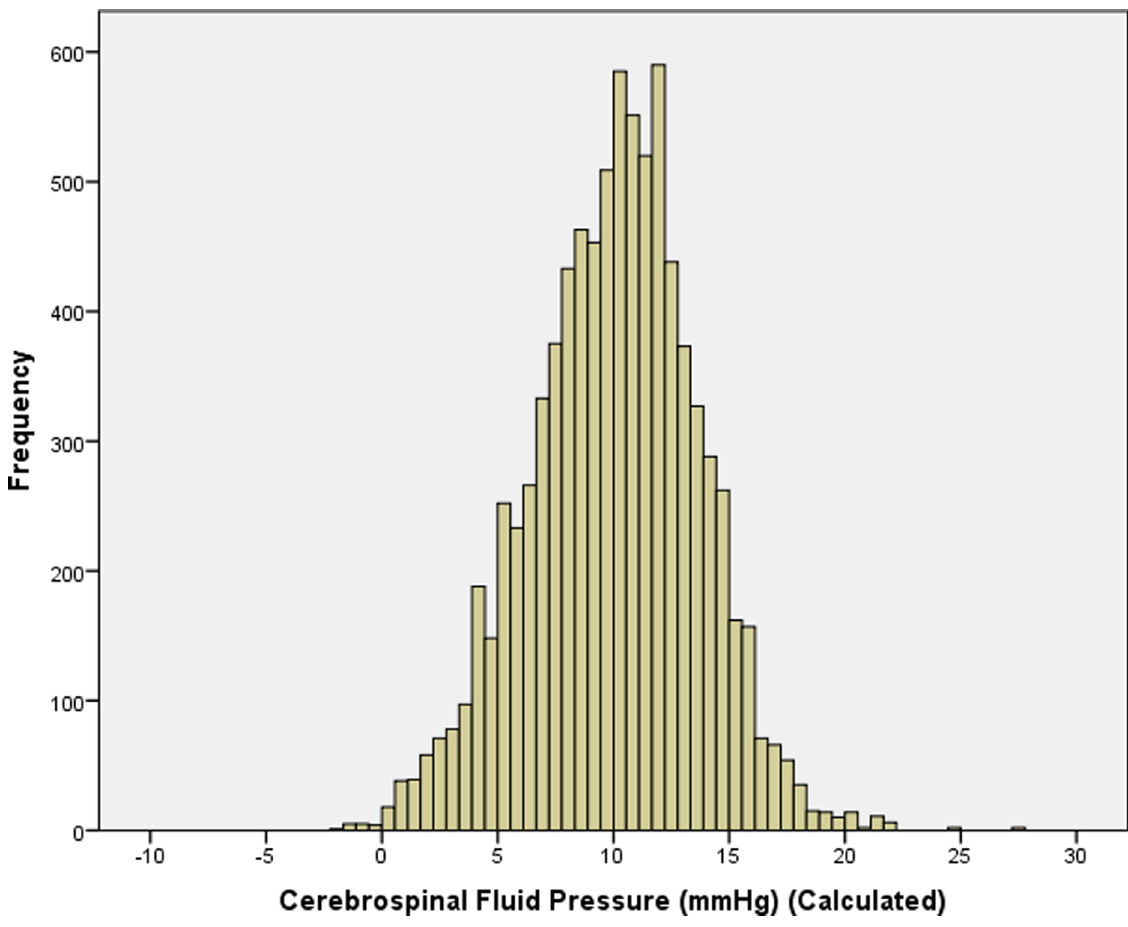
Figure 2. Histogram showing the distribution of the estimated cerebrospinal fluid pressure in the non-glaucomatous eyes of the Central India Eye and Medical Study.